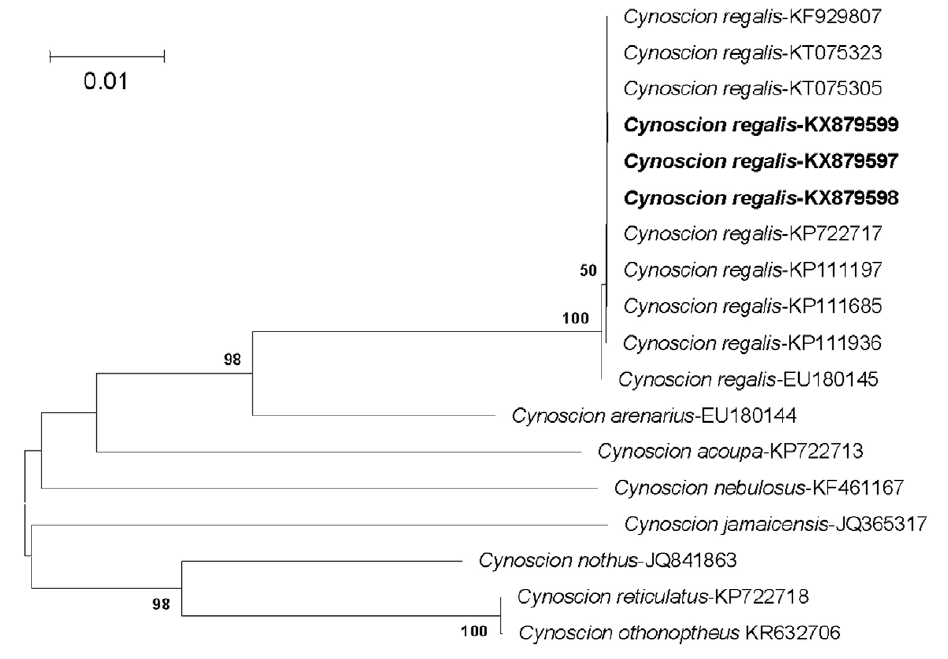
Fig. 3. – Topology of Neighbour-joining tree based on 611 bp of the 16S gene sequences, showing inferred phylogenetic relationships within the genus Cynoscion with Aplodinotus grunniens and Sciaenops ocellatus as outgroups. Numbers close to nodes indicate bootstrap support (only values above 50% shown). GenBank accession numbers are shown after name of species.